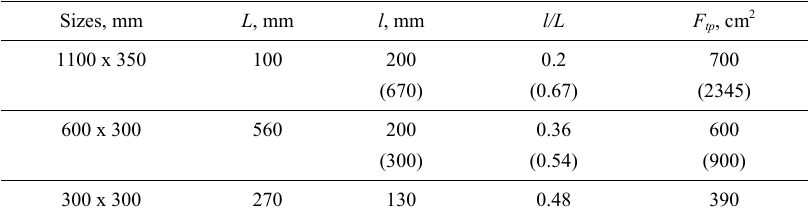
Table 1. Data on specimen series for bending tests of annealed and tempered